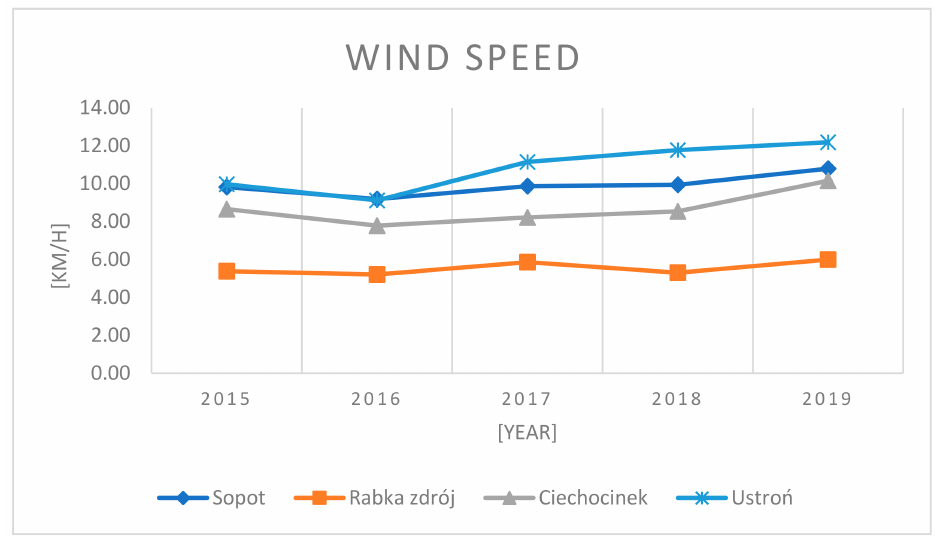
Figure 3. Average annual wind speed for health resorts communes in 2015–2019. The highest average relative humidity (Figure 4) of 2015–2019 during the analysis pe- riod is 77.30% and occurs in Sopot. In Rabka Zdr ó j the average relative humidity is 76.61%, in Ciechocinek, 75.64%, In the health resort of Ustro´n the average relative air humidity is 73.50% The development of basic statistics on meteorological elements is very important in order to determine their impact on concentration levels of harmful air pollutants. This is confirmed by numerous research works carried out by other researchers [34,35]. The relative humidity and air temperature [34] have the greatest impact on the con-centration of sulfur dioxide and particulate matter among meteorological elements. The level of par- ticulate matter pollution of the atmosphere largely depends on meteor-ological conditions, primarily the direction and speed of wind, relative humidity of air, the intensity of solar radiation [35].